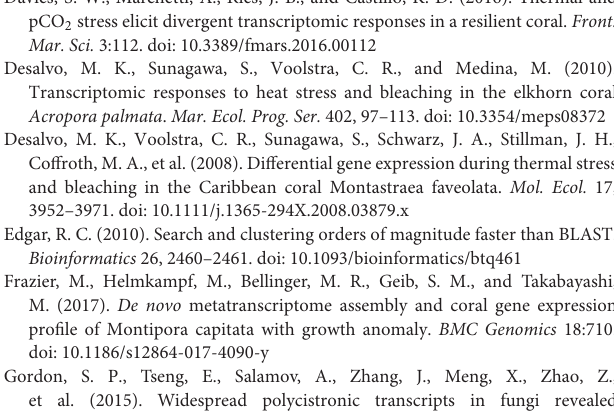
projects in coral species will greatly benefit from the annotated transcriptome assembly contributed in this